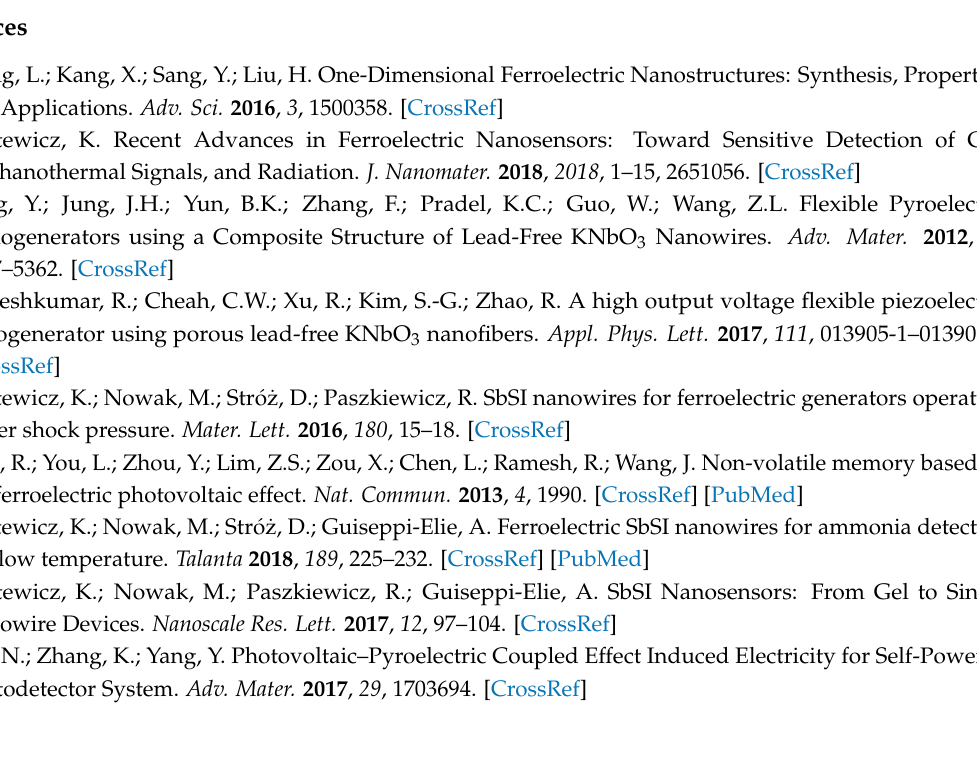
Figure S1: Influence of optical power density on (a) photoconductivity current (b) reciprocal of the electric resistance of SbSI FE-PV device at constant voltage bias of U=1 V. Red solid curves represent the best fitted dependence described by Eq. (S1); Values of the fitted parameters are given in the text; Blue dashed line and green arrow correspond to values of expressions σ d · S / d and ( σ ph + σ d ) S / d ,